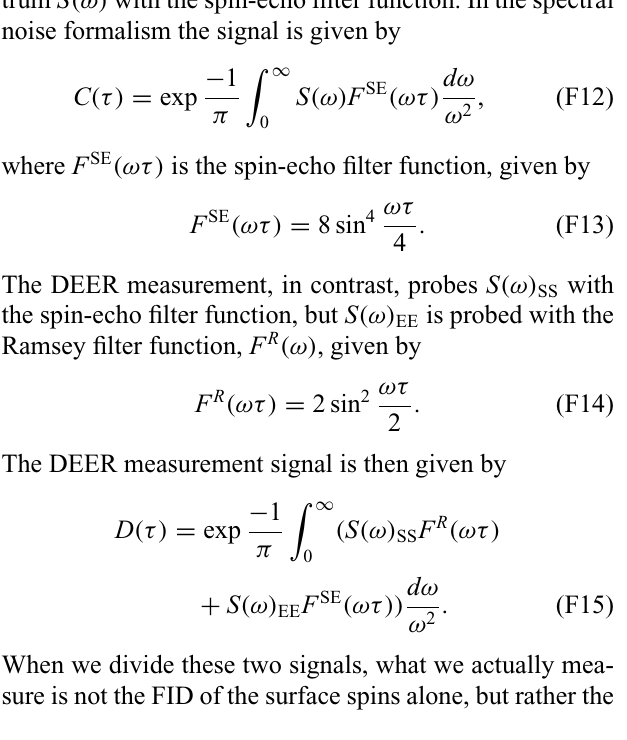
FIG. 15. Simulations with incoherent interactions. Example DEER curves for simulations allowing both flip flops and spin lattice relaxation between surface spins. Each color represents a differ- ent randomly sampled surface spin con- figuration. Fitting these curves with a stretched exponential produces values of 1 < n < 2. Some curves additionally show coherent oscillations if the cou- rate of incoherent